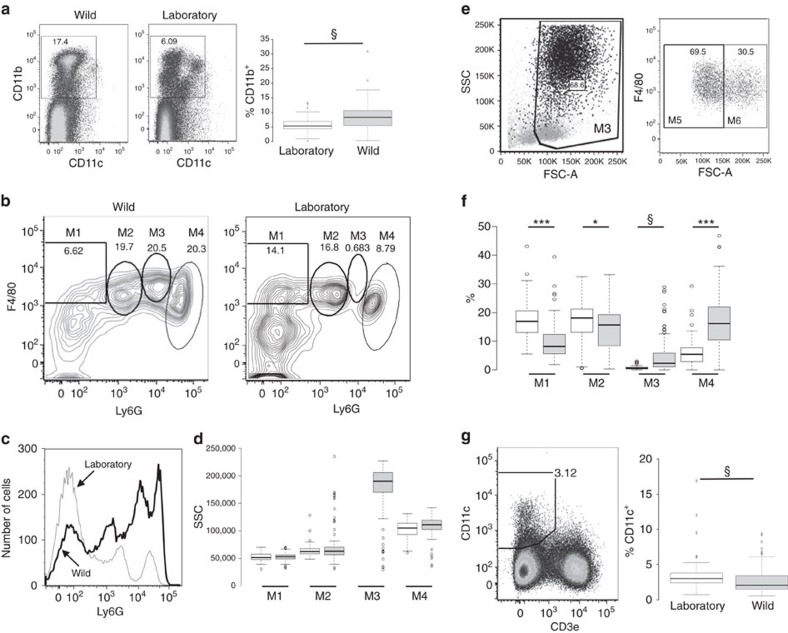
Myeloid cells.(a) The flow cytometry gating strategy to identify CD11b+ CD11c− myeloid cells and the proportion of myeloid cells among splenic leukocytes in wild (shaded) and laboratory (unshaded) mice, (b) gating myeloid cells on F4/80 and Ly6G expression to define M1 (tissue resident macrophages), M2 (monocytes), M3 (hypergranulocytic myeloid cells, HGMC) and M4 (polymorphonuclear leukocytes, PMN) subsets, (c) Ly6G expression confirming the presence of three cell populations in laboratory mice and four populations in wild mice, (d) side scatter characteristics of the M1–M4 populations in wild (shaded, n≥115) and laboratory (unshaded n≥57) mice; note that too few cells were present in the M3 gate in laboratory mice to accurately determine a side scatter statistic, (e) scatter characteristics of M3 (left) and M4 (right) cells, revealing a low forward scatter neutrophil population (M5) and a high forward scatter myeloid derived suppressor cell population (M6) among the M4 cells, (f) proportions of M1, M2, M3 and M4 subpopulations among the myeloid cell population in wild (shaded) and laboratory (unshaded) mice, and (g) gating of CD11c+ dendritic cells and their proportions among splenocytes in wild and laboratory mice. For the box plots, box centres are medians, and box limits the 25th and 75th percentiles, the whiskers 1.5 times the interquartile range and outliers are represented by dots. Asterisks denote significant differences as *P<0.05, ***P<0.001 (Mann–Whitney U test; Supplementary Table 2), and § denotes that there are additional sex effects detailed in Supplementary Table 2. Sample sizes are shown in Supplementary Table 2 and Supplementary Data 1.